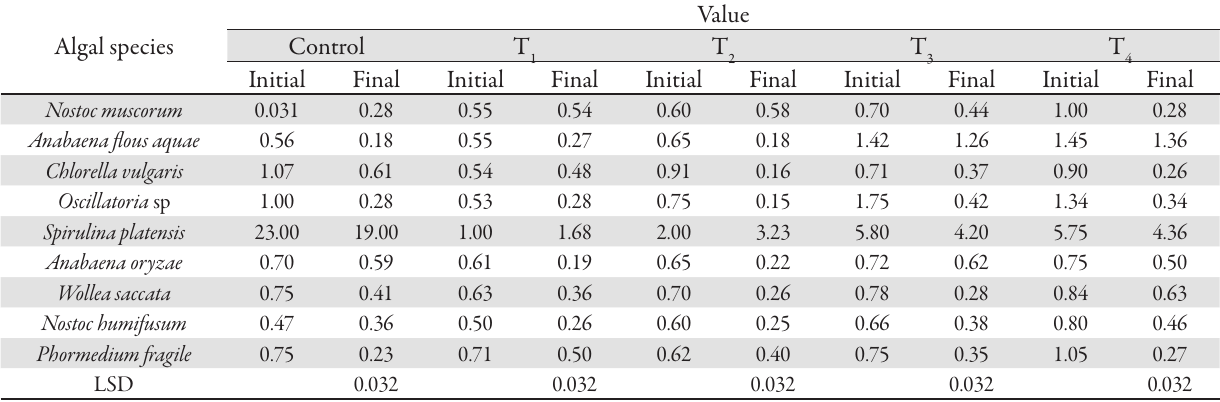
Tab. 4. Changes of electric conductivity (dsm -1 ) values of different microalgal cultures in wastewater during the treatment period Algal species